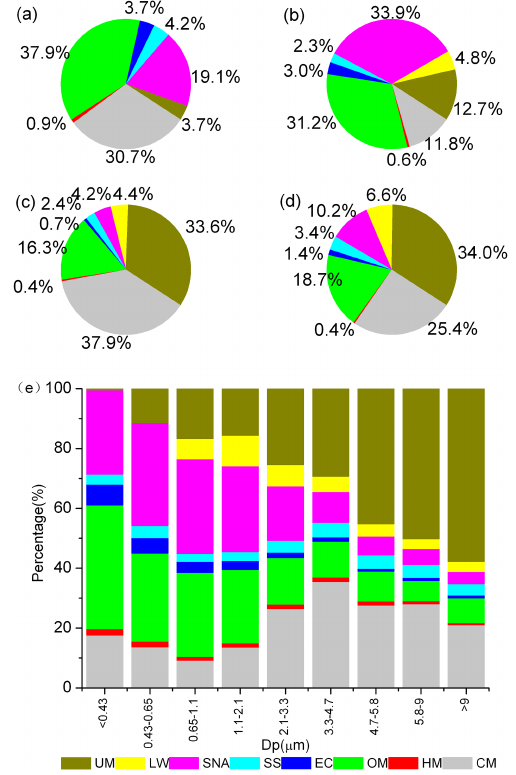
Figure 4. Contributions of different components to the total masses in (a) PM 2 . 1 on non-haze days, (b) PM 2 . 1 on haze days, (c) PM 2 . 1 − 9 on non-haze days, (d) PM 2 . 1 − 9 on haze days and (e) different size